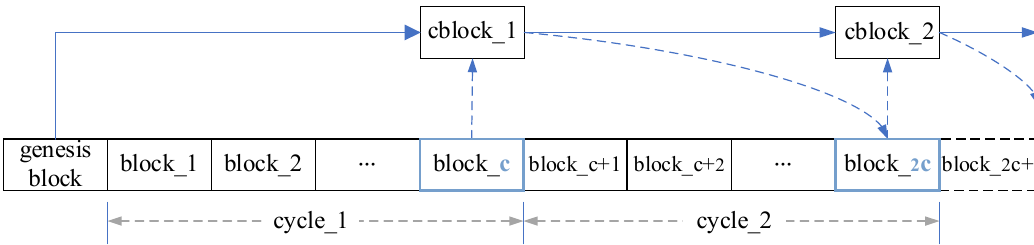
Figure 7. The main-side chain cross-anchoring structure.